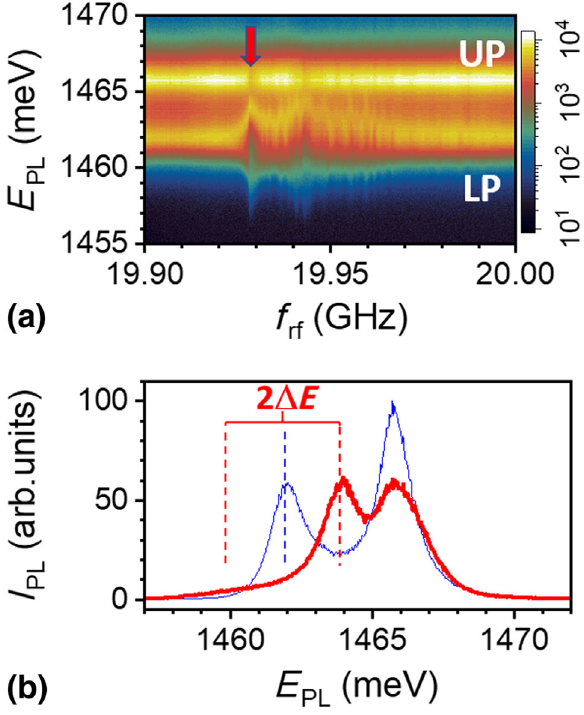
FIG. 7. Optomechanical response of a hybrid MC for 20-GHz BAWs. (a) The rf-frequency dependence of the PL recorded for a ¼ 24 dBm applied to the BAWR displaying fixed rf power P rf the effect of the BAWon the PL emission. The red arrow points at one of the acoustic resonances. The LP and UP stand for the lower-polariton branch and the upper-polariton branch, respec- tively. (b) Time-averaged PL spectra recorded at 10 K in the absence (thin blue line) and presence (thick red line) of a BAW ¼ 19 . 926 GHz [cf. red arrow in (a)]. The with frequency f BAW measurements are carried out at 10